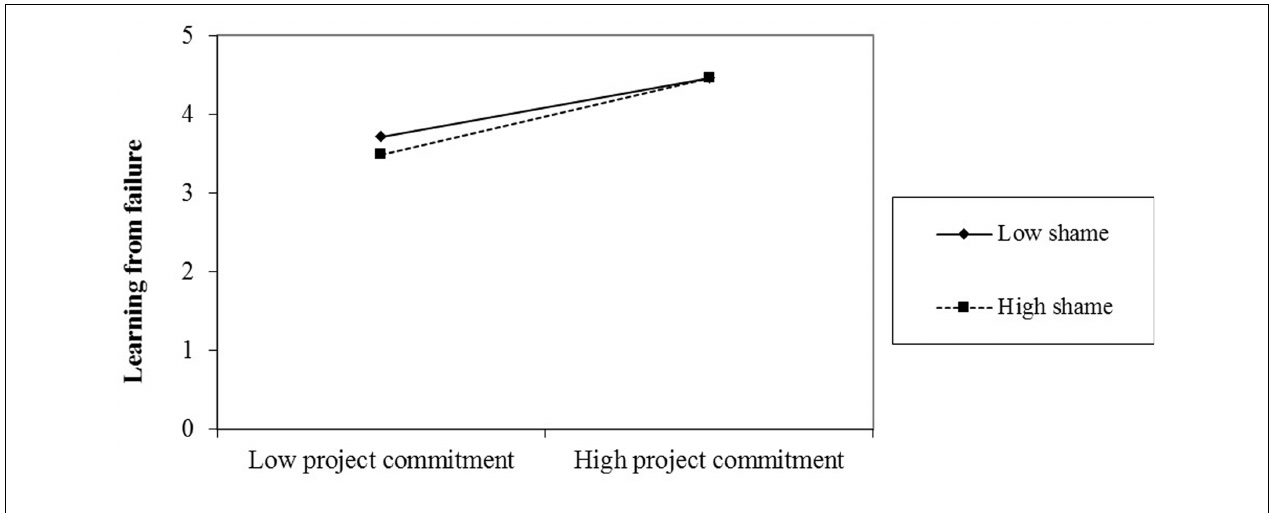
FIGURE 2 | The moderating effect of